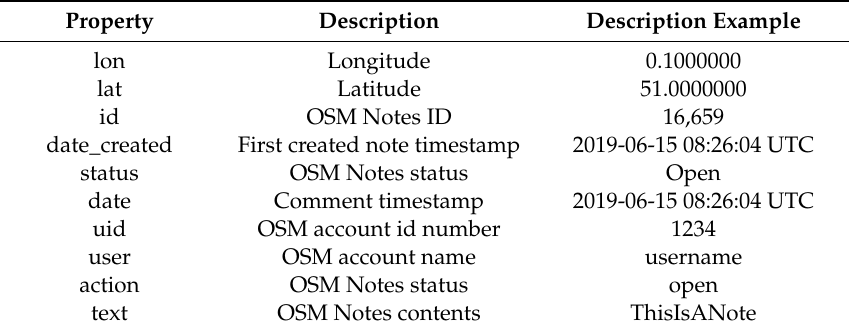
Table 2. OSM Notes properties in OSM Notes API